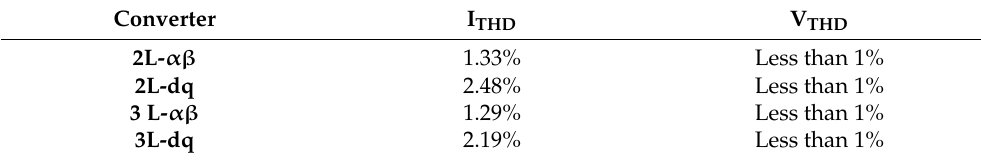
Table 3. Case 1 results.